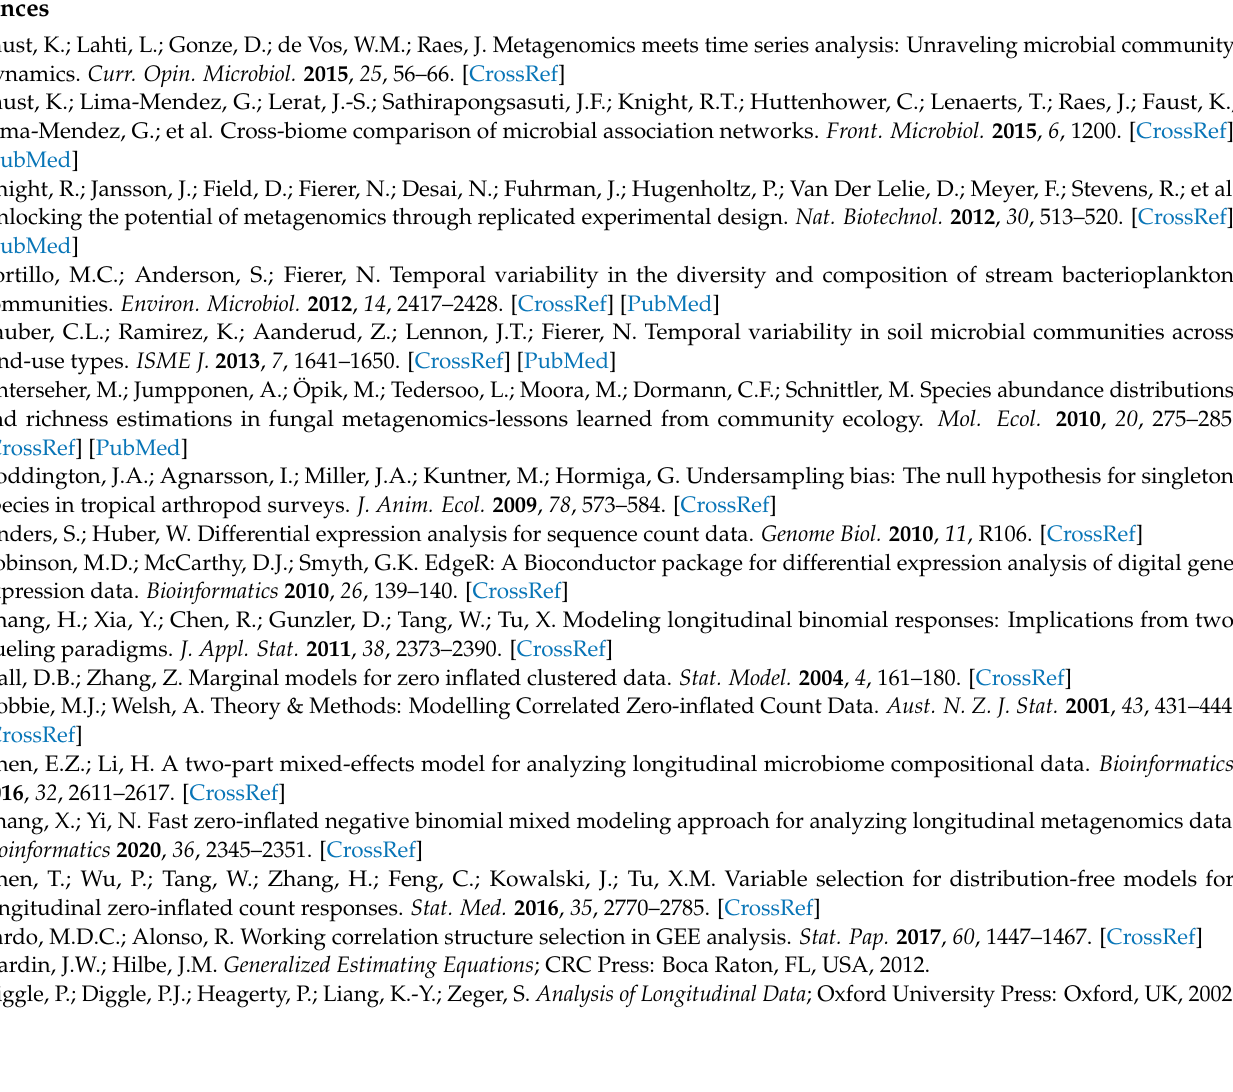
exchangeable correlation structure, Figure S2: Boxplots of Type I error rates under exchangeable correlation structure, Figure S3: Bar plots of the numbers of detected true and false positives under exchangeable correlation structure. Figure S4: Boxplots of the power for small number of subjects. Figure S5: Boxplots of Type I error rates for small number of subjects. Figure S6. Bar plots of the numbers of detected true and false positives for small number of